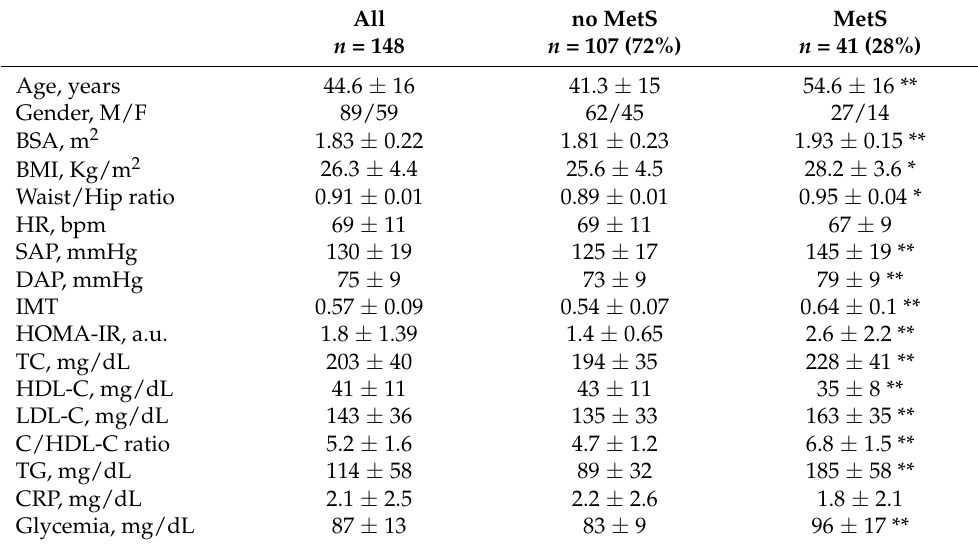
Table 1. Clinical characteristics for all enrolled subjects (All), those without metabolic syndrome (no MetS), and those with MetS